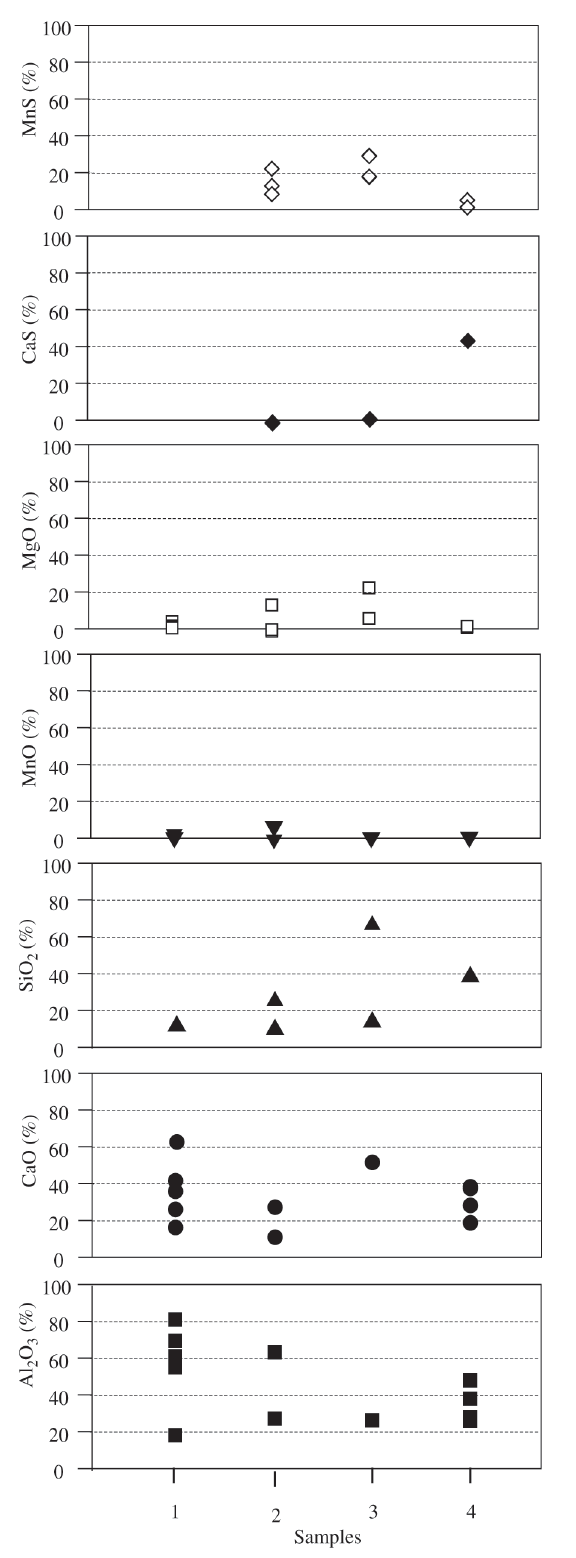
Figure 2. Evolution of the chemical composition of the inclusions in the samples of silicon killed SAE 1005